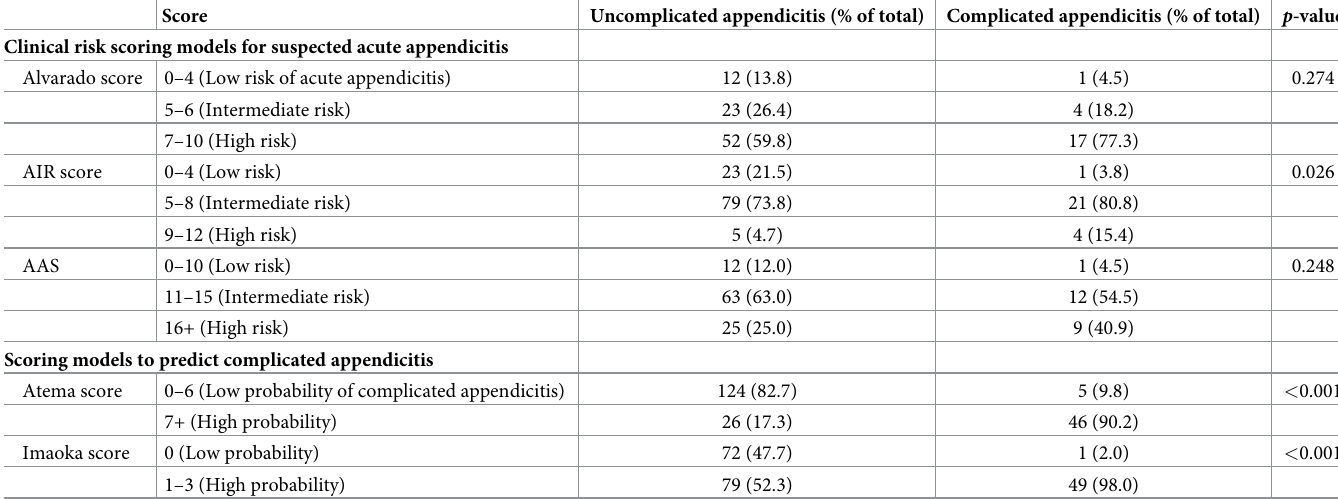
Table 3. Comparison between clinical scoring models for preoperative severity between uncomplicated and complicated appendicitis. Score